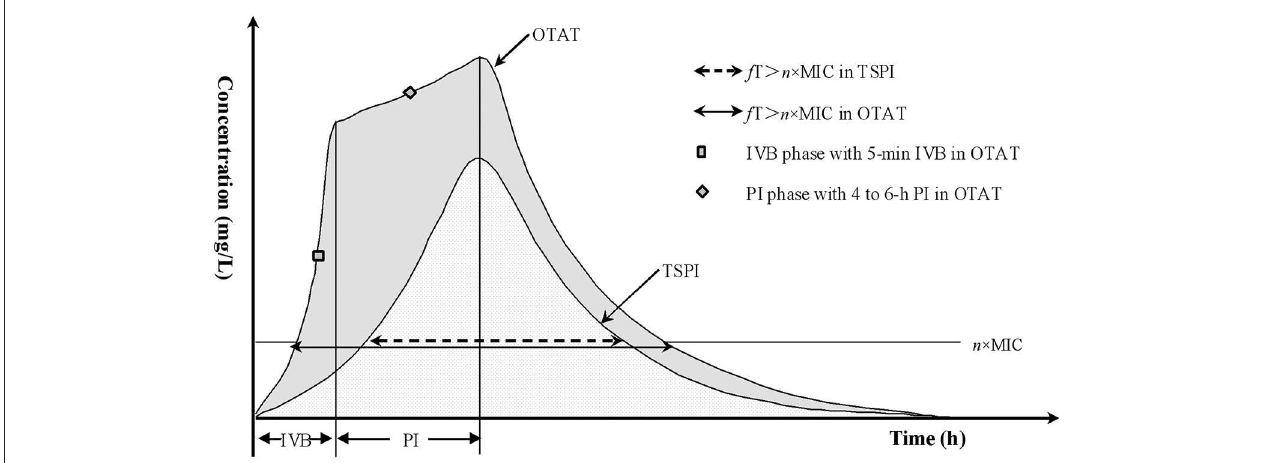
FIGURE 1 | Concentration-time profiles via TSPI and OTAT. IVB, i.v. bolus; PI, prolonged infusion; OTAT, optimized two-step-administration therapy; TSPI, traditional simple prolonged-infusion; MIC, minimum inhibitory concentration; f , fraction of unbound drug; f T > n × MIC, the time that the unbound (free) drug concentrations remain above the MIC by n